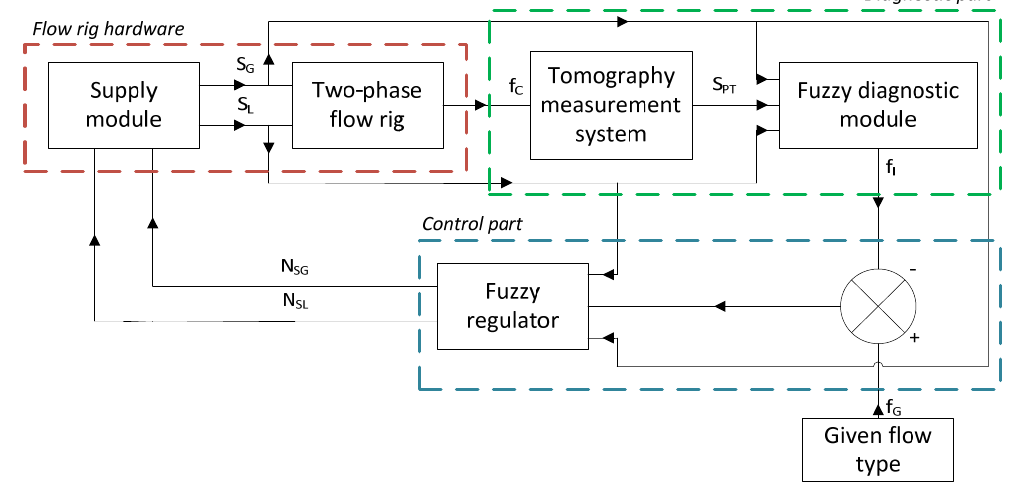
Figure 1. The flow rig diagnostic control system schema.